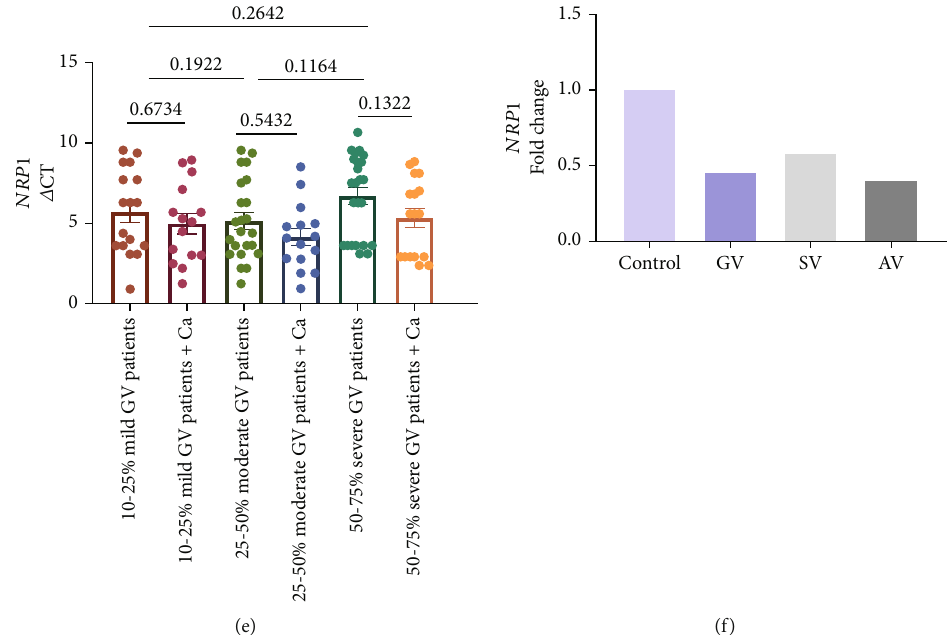
Figure 2: GZMB and NRP1 transcripts in Tregs of GV patients and controls. GZMB and NRP1 transcripts in Tregs of 52 GV patients and 48 controls were analyzed by Nonparametric Mann – Whitney U test. (a) GZMB transcripts in GV, SV, and AV vs controls ’ Tregs ( p = 0 : 03 , p = 0 : 038 , and p < 0 : 0001 , respectively). GZMB transcripts in AV vs SV Tregs ( p = 0 : 019 ). GZMB transcripts in GV, SV, and AV Tregs before and after calcium treatment ( p = 0 : 023 , p = 0 : 0328 , and p = 0 : 01 ). (b) GZMB transcripts in 50-75% severe GV vs 10-25% mild GV Tregs ( p = 0 : 034 ). GZMB transcripts in moderate GV (25-50% VASI) vs mild GV (10-25% VASI) and severe GV (50-75% VASI) Tregs ( p = 0 : 1162 and p = 0 : 1164 , respectively). GZMB transcripts in mild GV, moderate GV, and severe GV Tregs before and after calcium treatment ( p = 0 : 034 , p = 0 : 022 , and p = 0 : 01 ). (c) There was a 0.44-, 0.58-, and 0.30-fold changes in GZMB transcripts for GV, SV, and AV Tregs as compared to controls. (d) NRP1 transcripts in GV, SV, and AV vs controls ’ Tregs ( p = 0 : 023 , p = 0 : 044 , and p = 0 : 001 , respectively). NRP1 transcripts in AV vs SV Tregs ( p = 0 : 453 ). NRP1 transcripts in GV, SV, and AV Tregs before and after